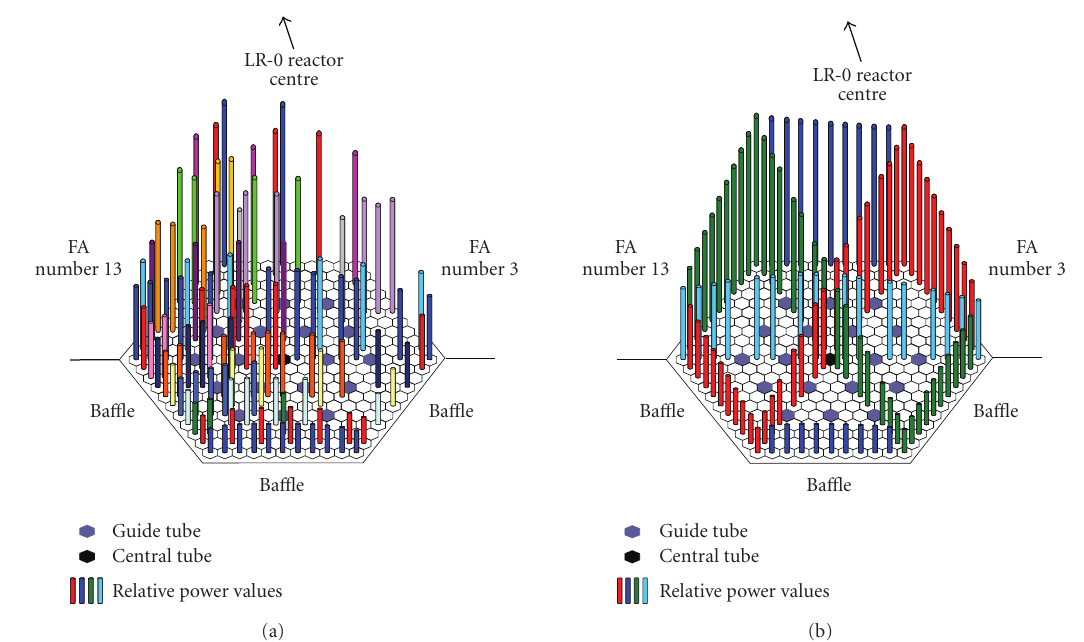
Figure 5: (a) Experimental and (b) calculation power distribution values in selected FP positions in FA no. 4.